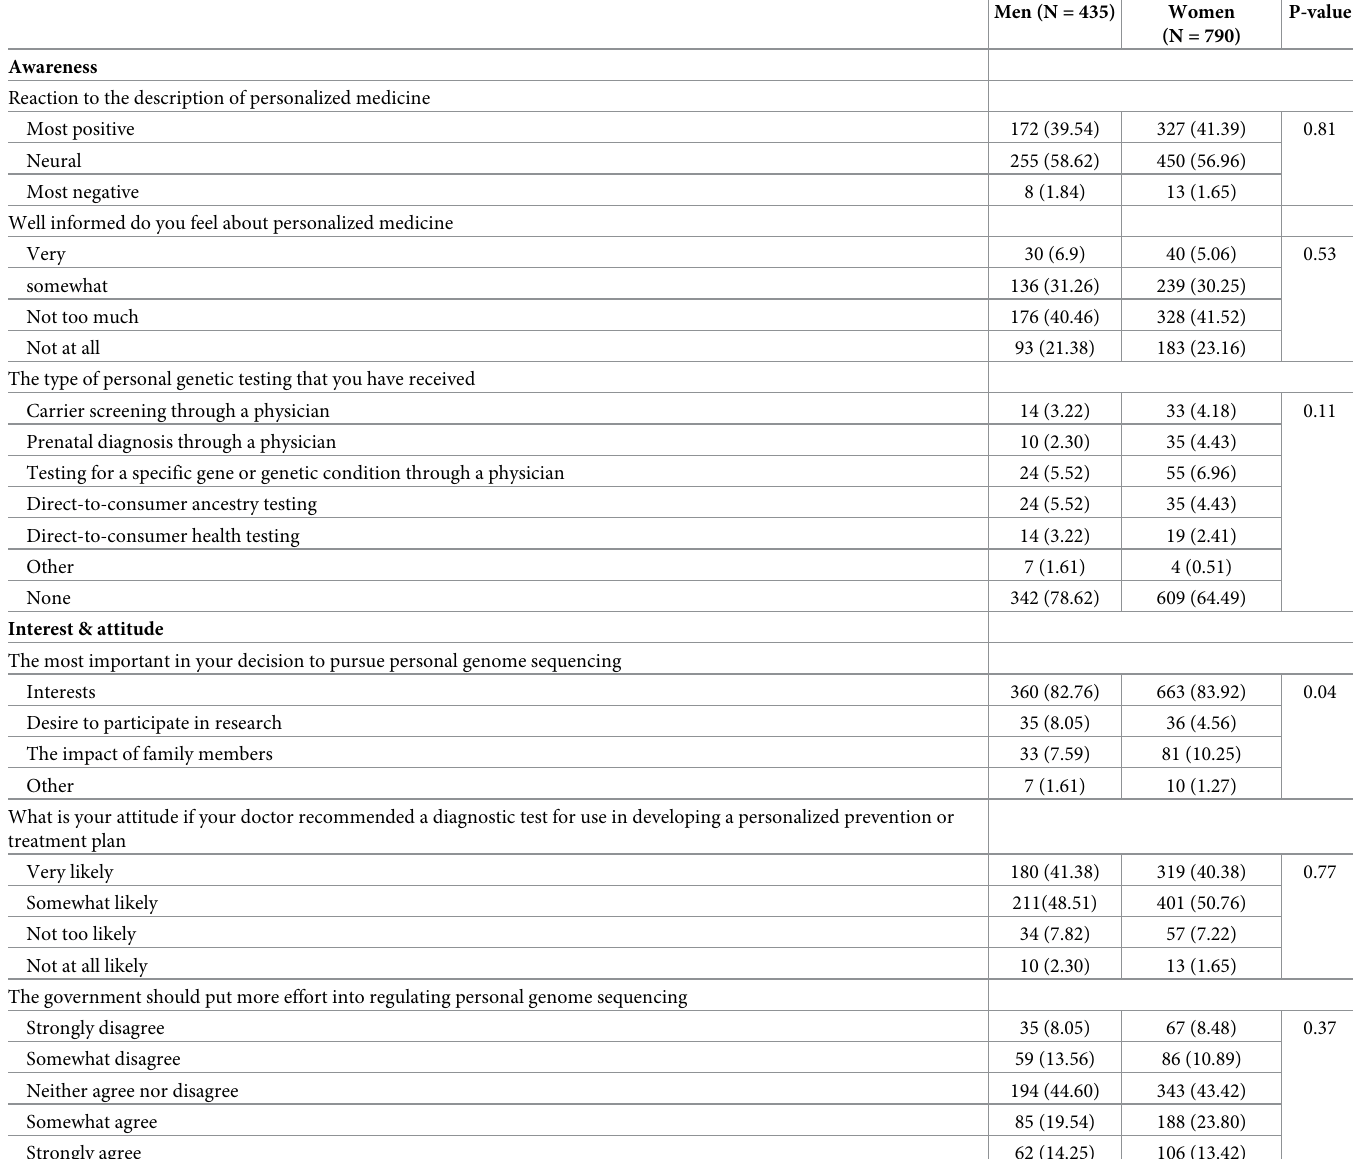
Table 2. Respondent awareness and interest in personalized medicine by